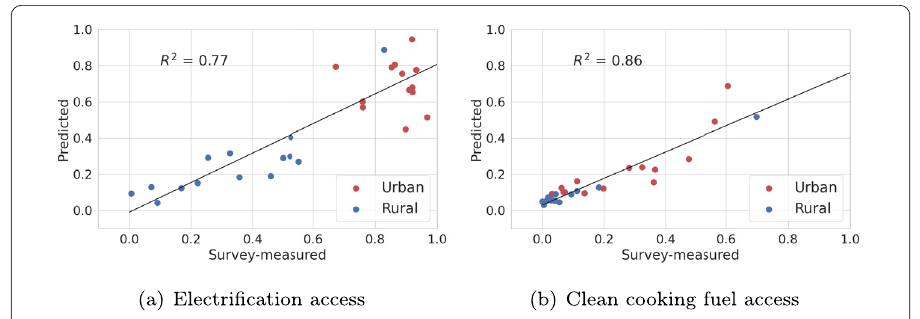
Figure 1 Scatter plots of temporal validation of nowcasts for 2020 with DHS derived data for 2019 for energy access at regions. Our model predictions are produced at microregions, but aggregated to regions for comparison. Targets from DHS clusters are assigned to their regions as